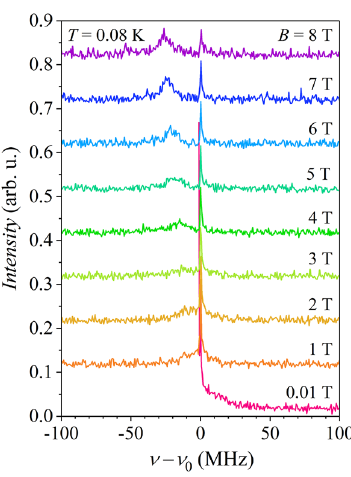
Figure 2. Muon spin rotation time-domain data measured at consecutive muon spin precession signals are offset by 5. Solid curves are fits with Eq. (1).